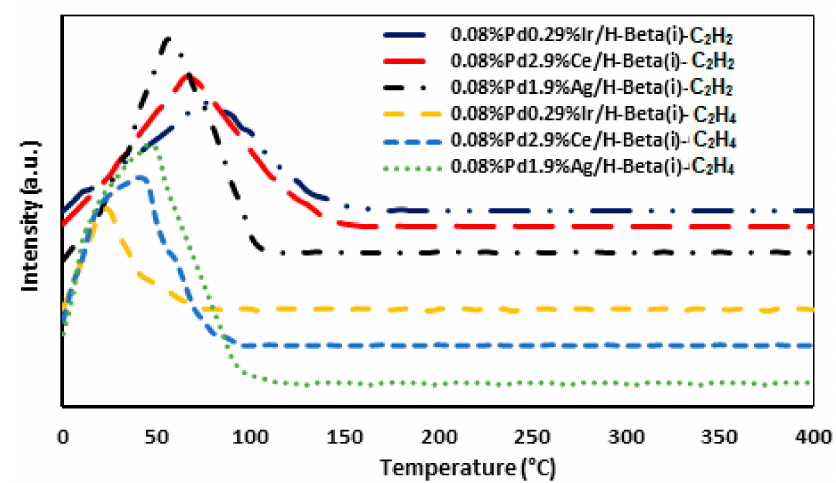
Figure 13. Temperature programmed desorption (TPD) pattern of acetylene and ethylene desorption on optimum catalysts.